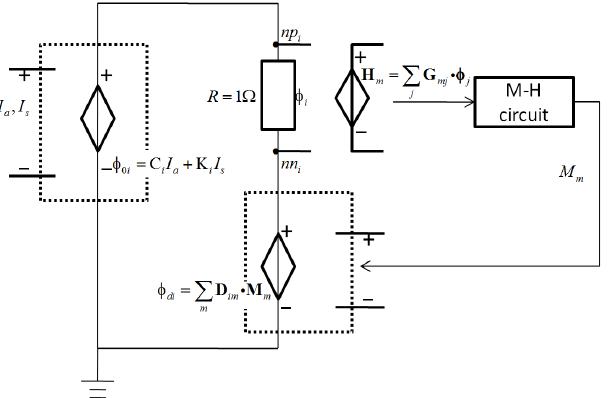
Figure 3. Circuit diagram of the i-th MSP-VIE sub-equation.